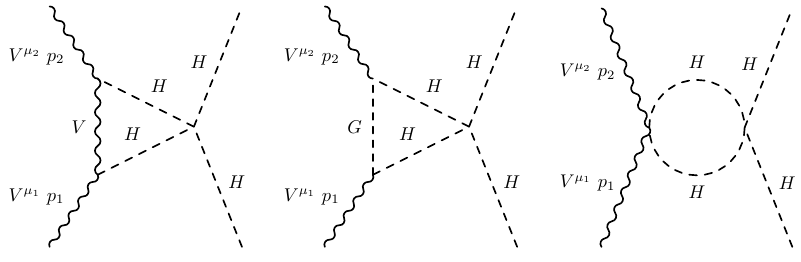
Figure 21 . Feynman diagrams contributing to the V 01 [ HHV V ] form factor.